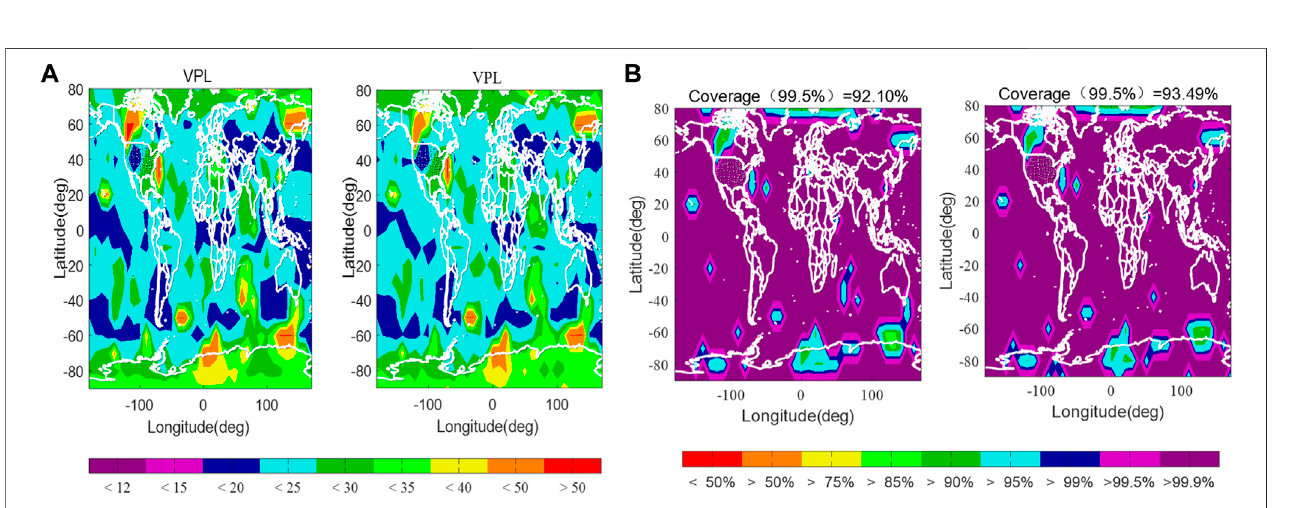
Frontiers in Energy Research |